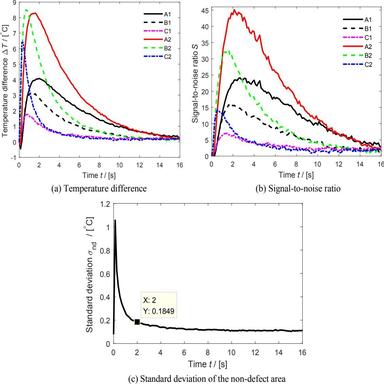
Experimental informative parameter evolutions of sample A.